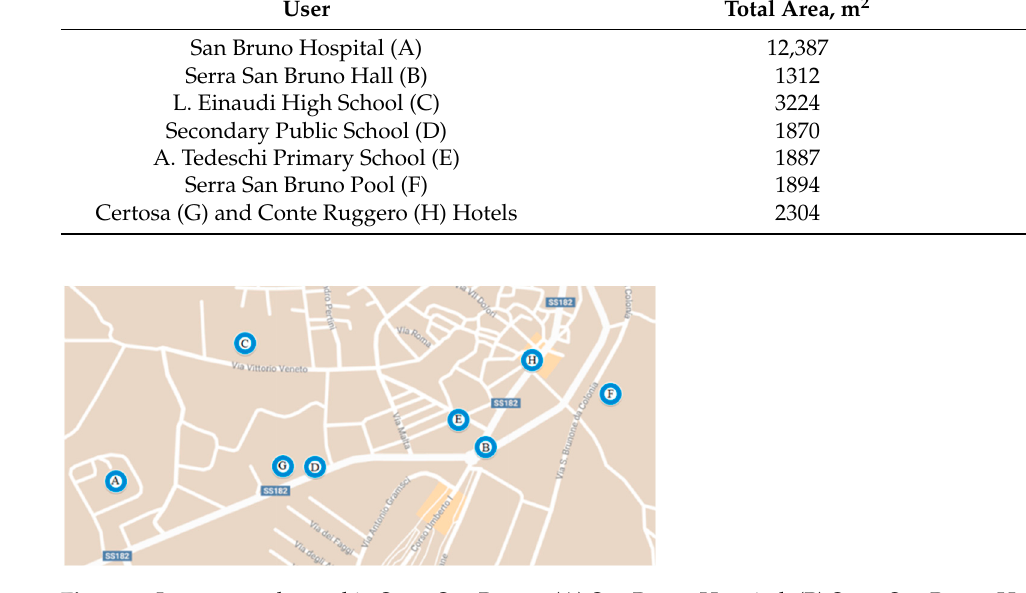
Table 1. Large users characteristics.